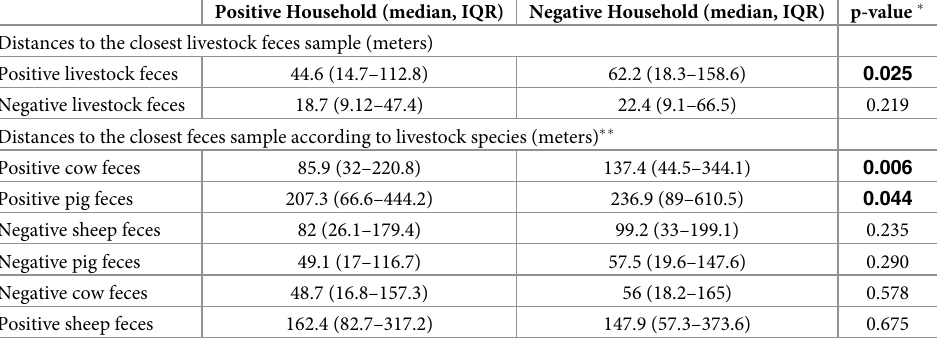
Table 3. “Median distances from Fasciola positive or negative households to closest positive or negative livestock feces sample”. Positive Household (median, IQR) Negative Household (median, IQR) p-value � Distances to the closest livestock feces sample (meters)